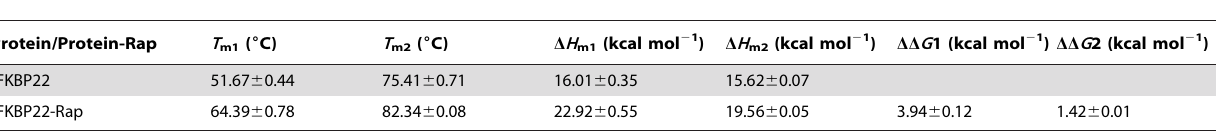
Table 2. Thermodynamic parameters for the heat-induced unfolding of proteins a .